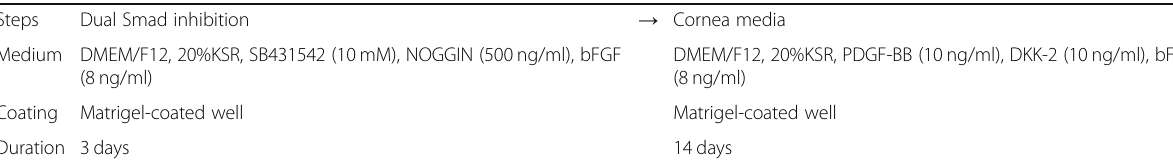
Table 3 The summary of McCabe ’ s methods (2015) Steps